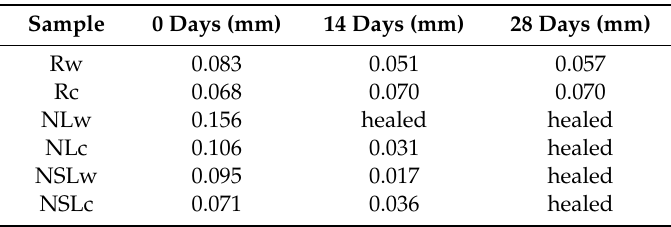
Figure 7. Optical microscopy observation of the cement pastes at 28 + 0 days of the cracking, at 28 + 14 days and 28 + 28 days, cured in water immersion (w) and wetting-drying cycles (c) (Scale equals to 1 mm). Table 6. Crack width evolution (mean values of 14 measurements).